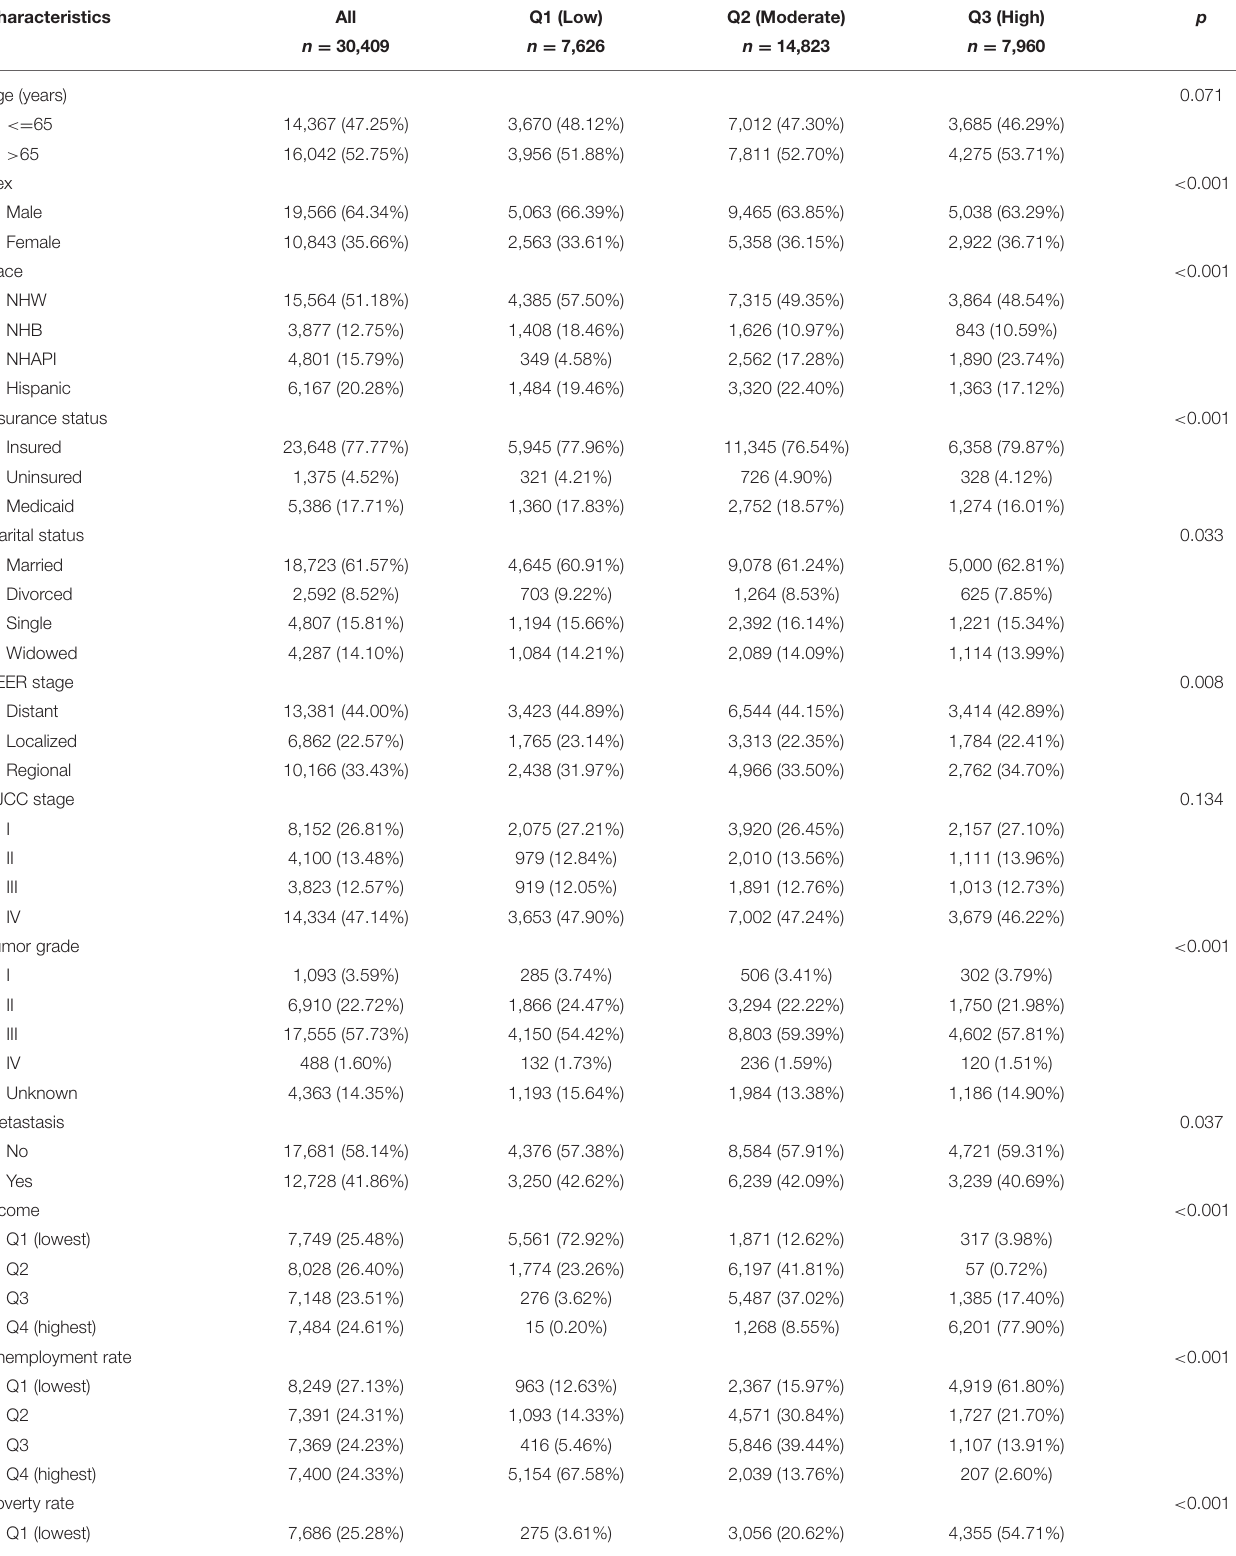
TABLE 1 | Baseline characteristics of patients with GAC grouped by education level.